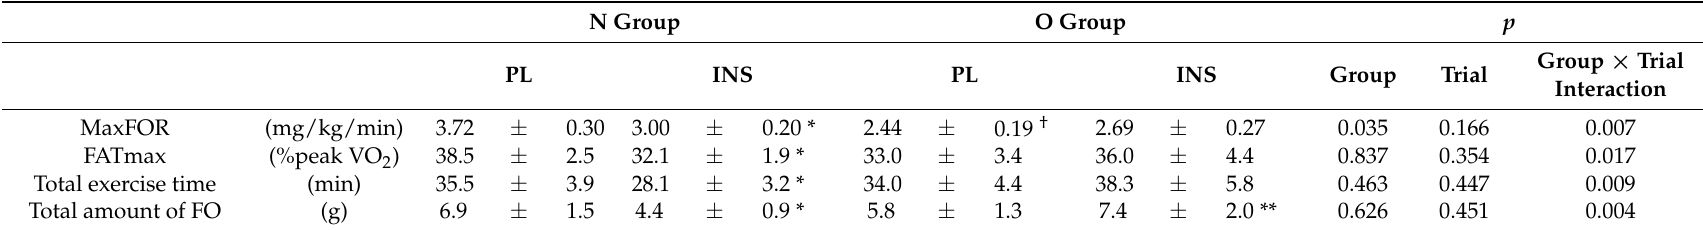
Table 3. Parameter regarding fat oxidation during graded exercise in both